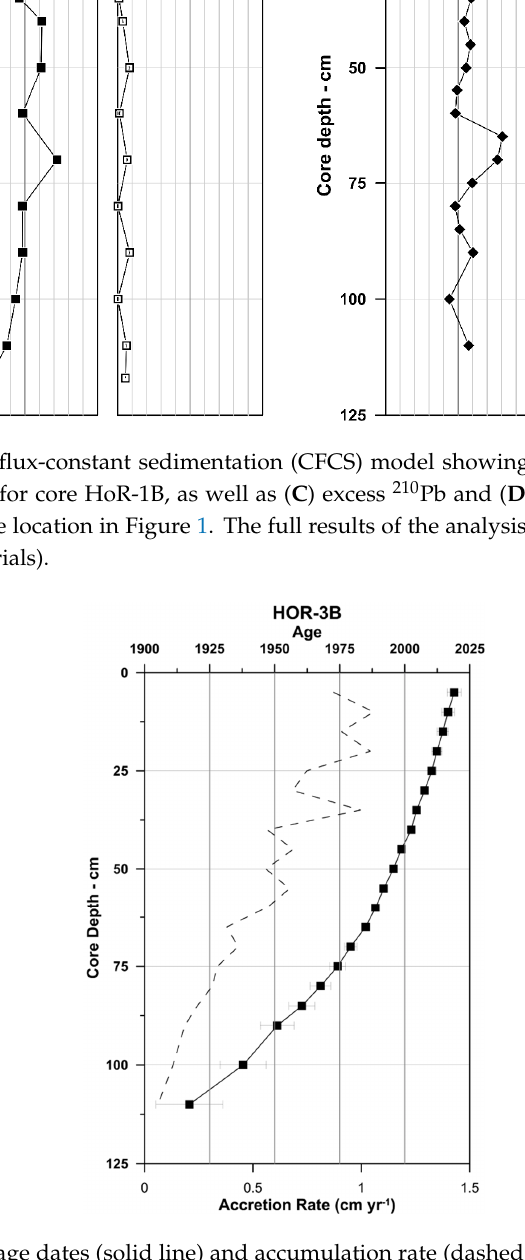
Figure 11. Sediment age dates (solid line) and accumulation rate (dashed line) calculated using the constant rate of supply (CRS) model. See Figure 1 for the location of the core. The full results of the analysis are available in Table S7 (Supplementary Materials).